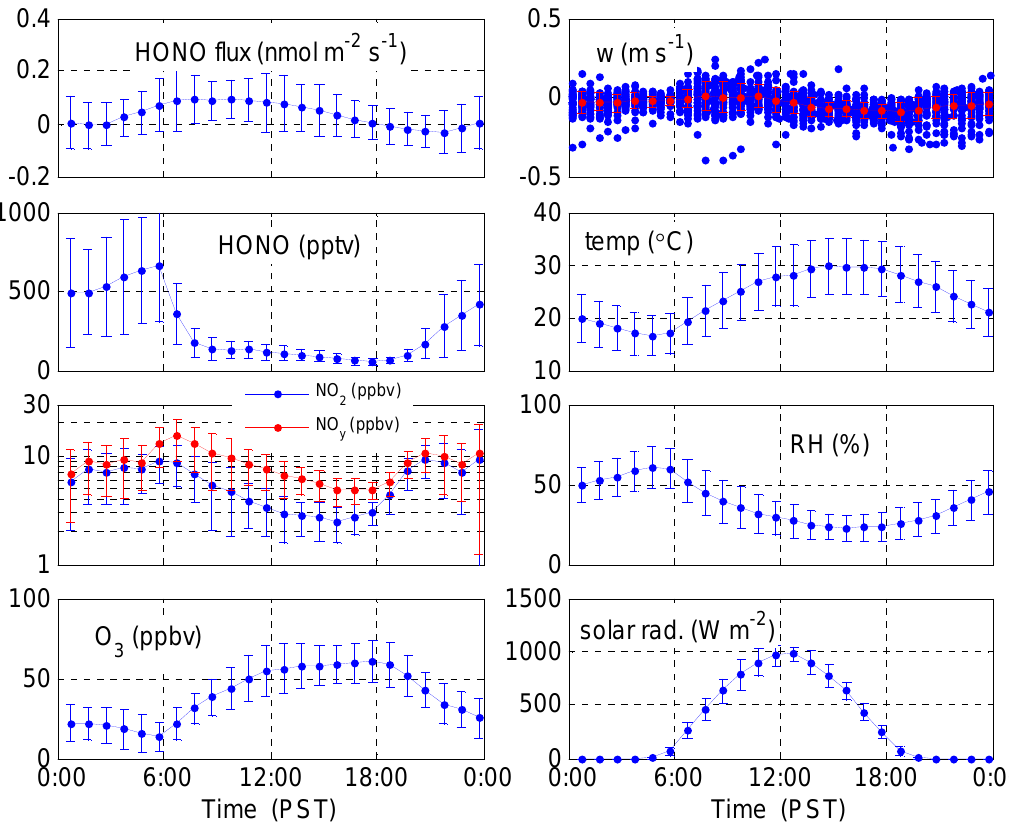
Fig. 3. Composite diurnal variations of HONO flux, HONO, NO 2 /NO y , O 3 , vertical wind velocity ( w ), temperature, relative humidity (RH) and solar radiation measured during the CalNex 2010 field study. Hourly diurnal mean values are shown and error bars represent 1 σ deviations of the measurements in the hourly bins. For vertical wind velocity ( w ), individual 30-min averages are also plotted as blue dots to show the variations in the data.